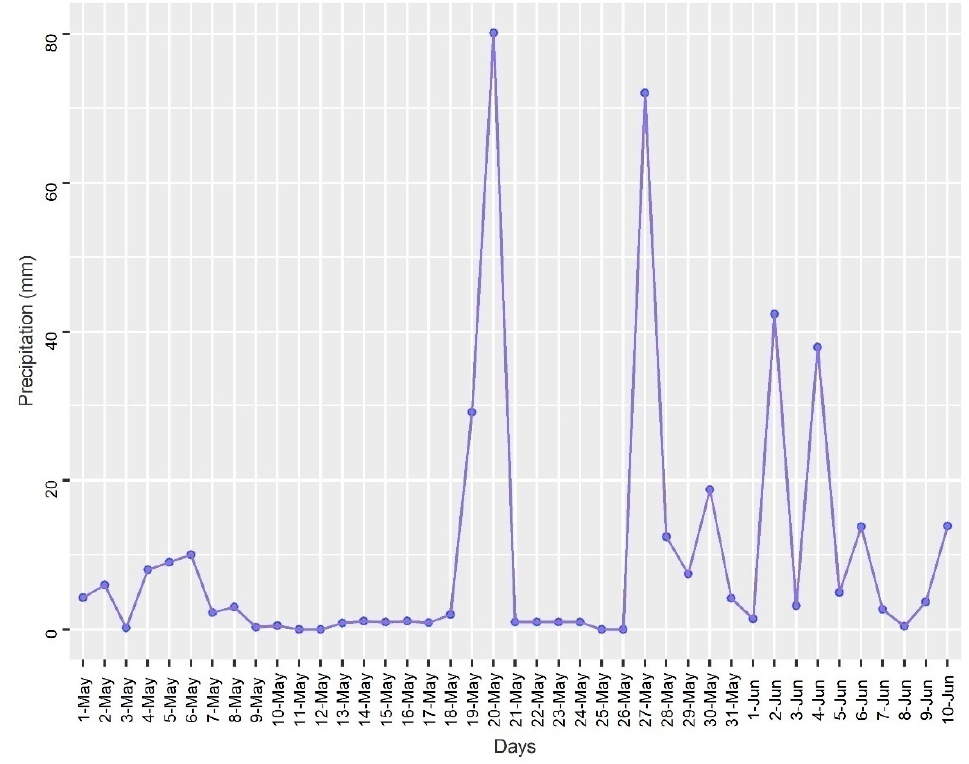
Figure 8. Average precipitation in the study area from 1 May to 10 June 2020.